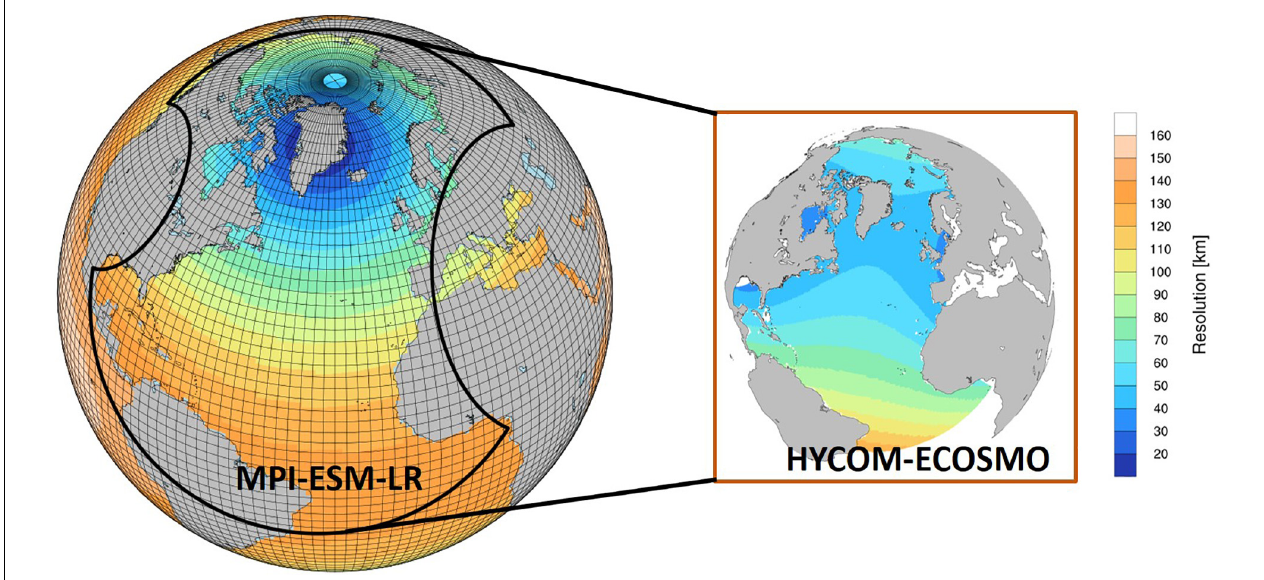
FIGURE 2 | Sketch of the downscaling prediction system. Decadal predictions with the coupled Max Planck Institute Earth System Model with low-resolution configuration (MPI-ESM-LR) provide surface and lateral boundary conditions to the regional coupled physical-ecosystem model HYCOM-ECOSMO. Colors illustrate the horizontal resolution of the ocean models. Grid lines over the global model show the grid of the atmospheric model. Note not all grid-lines are